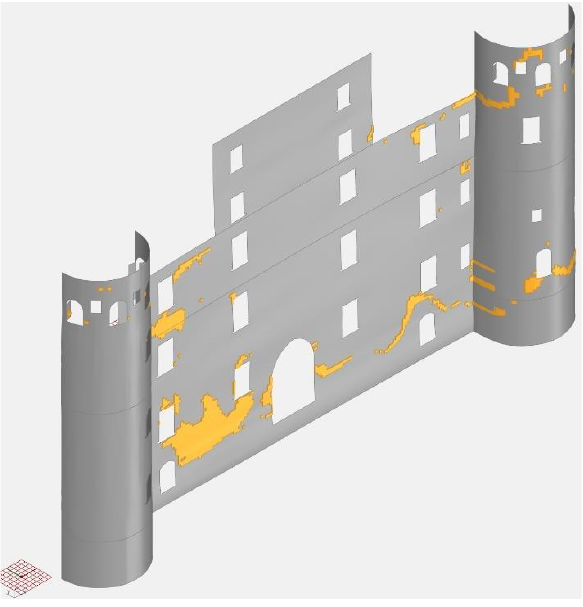
Figure 15. Grasshopper environment: surfaces projected on imported model using VPL.